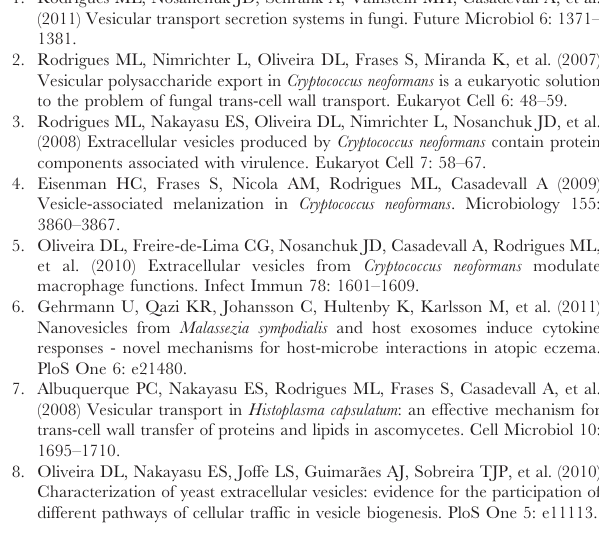
Figure S4 Tandem-MS spectrum of a major phosphati- dylserine (PS) species (C16:0/C18:2-PS). Samples were dissolved in methanol, containing 0.05% FA, 0.05% NH 4 OH, and